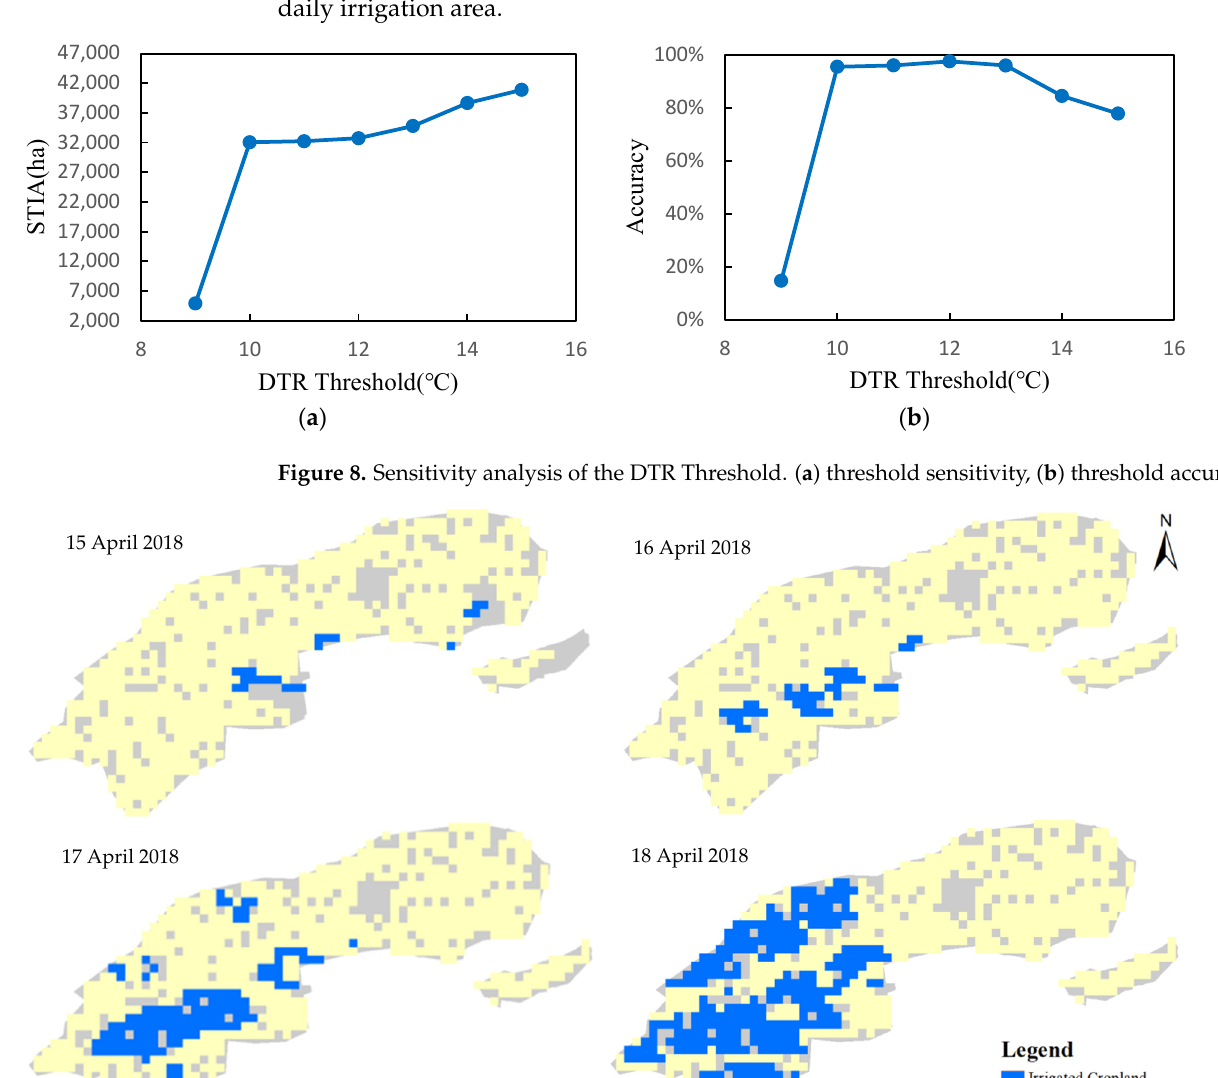
Figure 9. Spatial distribution of NIA from 15 April 2018 to 18 April 2018.